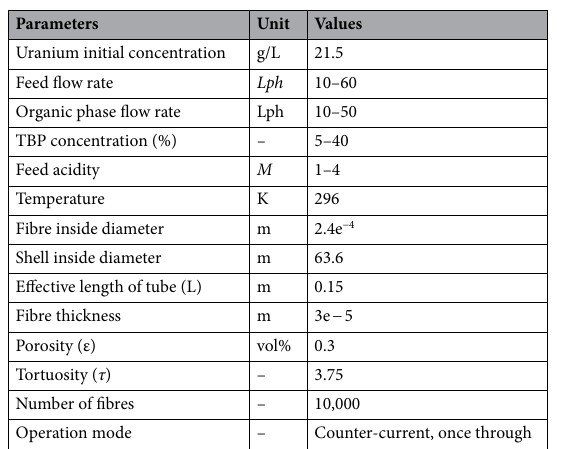
Table 1. The extractor’s parameters, as well as the characteristics of the fluids and the operating conditions 17,26 .